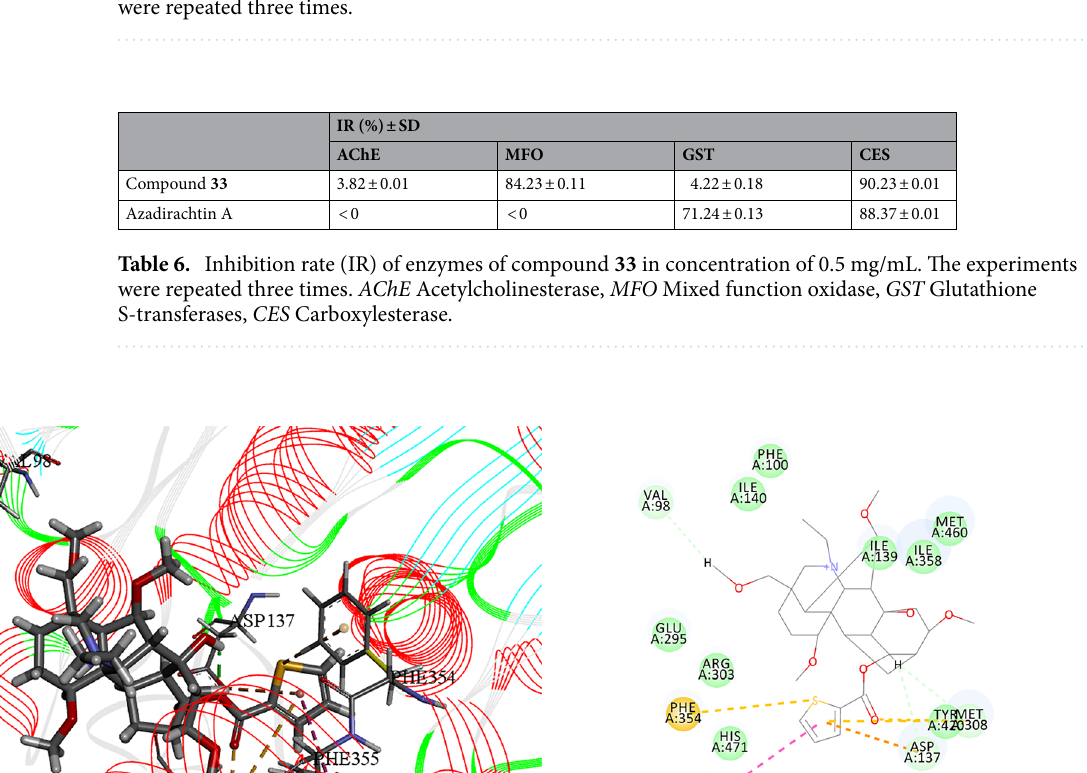
Table 5. Lethal concentration 50% (LC 50 ) of compound 10 and 30 against Spodoptera exigua. The experiments were repeated three times.